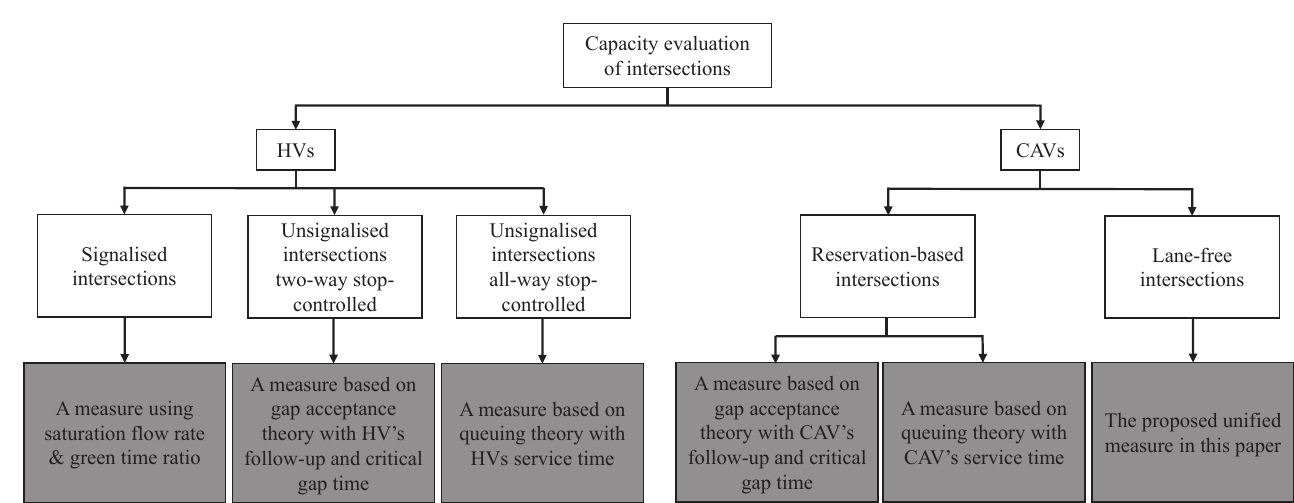
Figure 1. The measures for capacity evaluation of intersections (grey boxes) with both the human- driven vehicles (HVs) and connected and autonomous vehicles